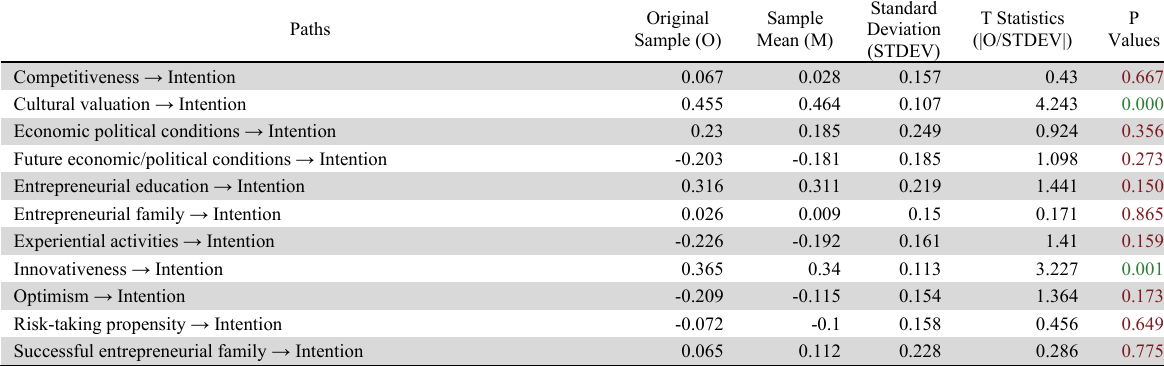
Study paths' coefficients for hypothesis